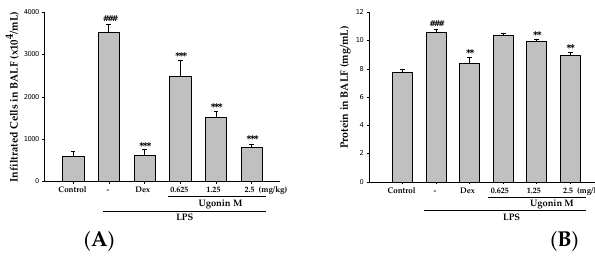
Figure 5. Effects of Ugonin M on: ( A ) infiltrated cellular counts; and ( B ) total proteins in BALF. Each value represents as the mean ± SD of six mice. ### p < 0.001 was compared with a sample of the control group (One-way ANOVA followed by Scheffe’s multiple range tests). ** p < 0.01 and *** p < 0.001 were compared with the LPS-only group.